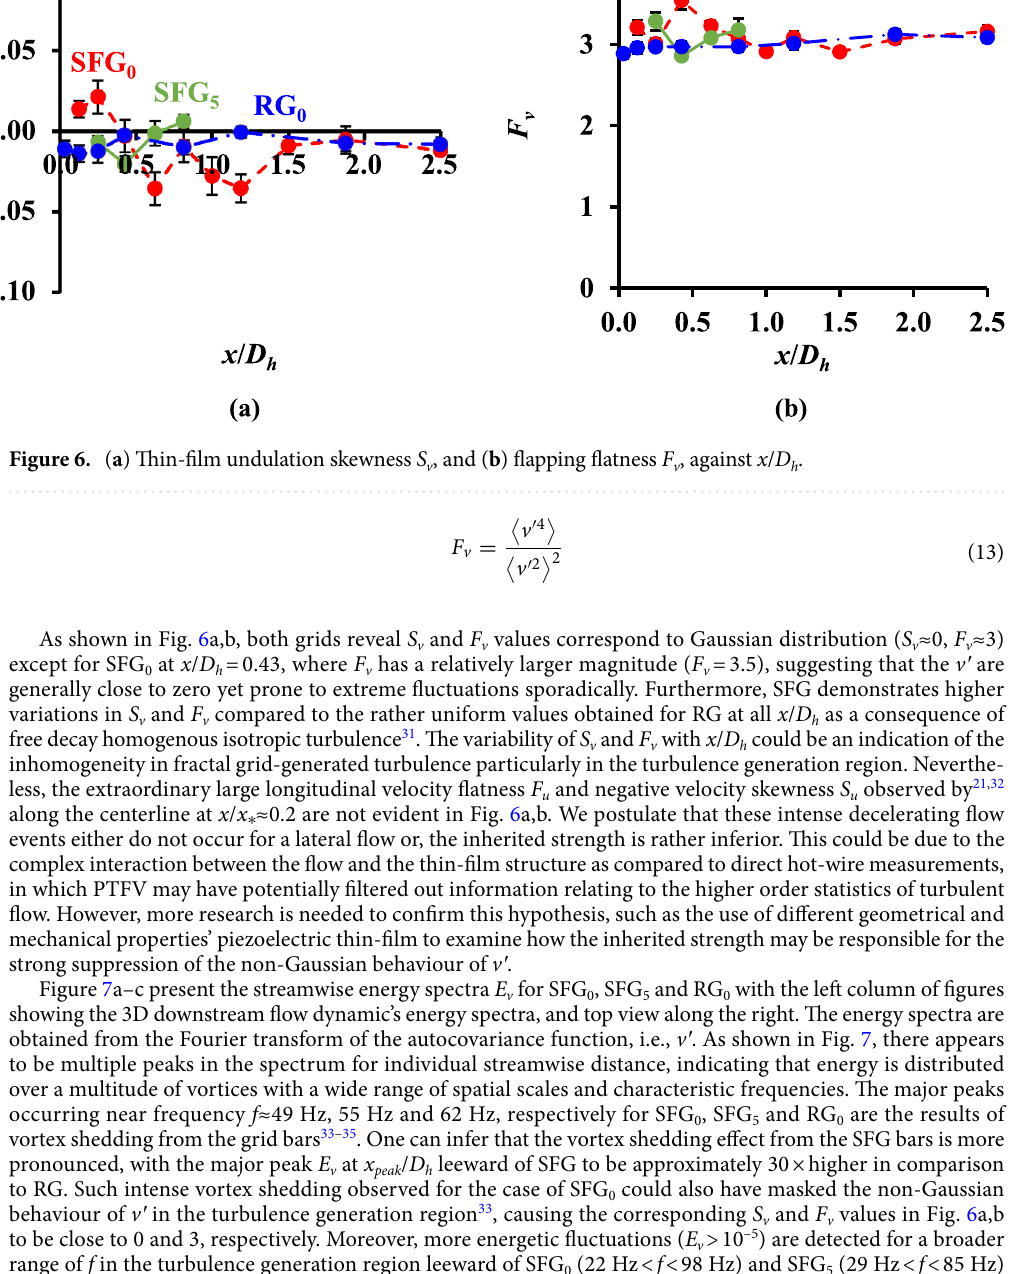
As shown in Fig. 6a,b, both grids reveal S v and F v values correspond to Gaussian distribution ( S v ≈0, F v ≈3) except for SFG 0 at x / D h = 0.43, where F v has a relatively larger magnitude ( F v = 3.5), suggesting that the v ′ are generally close to zero yet prone to extreme fluctuations sporadically. Furthermore, SFG demonstrates higher variations in S v and F v compared to the rather uniform values obtained for RG at all x / D h as a consequence of free decay homogenous isotropic turbulence 31 . The variability of S v and F v with x / D h could be an indication of the inhomogeneity in fractal grid-generated turbulence particularly in the turbulence generation region. Neverthe- less, the extraordinary large longitudinal velocity flatness F u and negative velocity skewness S u observed by 21,32 along the centerline at x / x ≈0.2 are not evident in Fig. 6a,b. We postulate that these intense decelerating flow ∗ events either do not occur for a lateral flow or, the inherited strength is rather inferior. This could be due to the complex interaction between the flow and the thin-film structure as compared to direct hot-wire measurements, in which PTFV may have potentially filtered out information relating to the higher order statistics of turbulent flow. However, more research is needed to confirm this hypothesis, such as the use of different geometrical and mechanical properties’ piezoelectric thin-film to examine how the inherited strength may be responsible for the strong suppression of the non-Gaussian behaviour of v ′ . Figure 7a–c present the streamwise energy spectra E v for SFG 0 , SFG 5 and RG 0 with the left column of figures showing the 3D downstream flow dynamic’s energy spectra, and top view along the right. The energy spectra are obtained from the Fourier transform of the autocovariance function, i.e., v ′ . As shown in Fig. 7, there appears to be multiple peaks in the spectrum for individual streamwise distance, indicating that energy is distributed over a multitude of vortices with a wide range of spatial scales and characteristic frequencies. The major peaks occurring near frequency f ≈49 Hz, 55 Hz and 62 Hz, respectively for SFG 0 , SFG 5 and RG 0 are the results of vortex shedding from the grid bars 33–35 . One can infer that the vortex shedding effect from the SFG bars is more pronounced, with the major peak E v at x peak / D h leeward of SFG to be approximately 30 × higher in comparison to RG. Such intense vortex shedding observed for the case of SFG 0 could also have masked the non-Gaussian behaviour of v ′ in the turbulence generation region 33 , causing the corresponding S v and F v values in Fig. 6a,b to be close to 0 and 3, respectively. Moreover, more energetic fluctuations ( E v > 10 –5 ) are detected for a broader range of f in the turbulence generation region leeward of SFG 0 (22 Hz < f < 98 Hz) and SFG 5 (29 Hz < f < 85 Hz) as compared to RG 0 (53 Hz < f < 69 Hz), suggesting that SFG-induced turbulence contains more effective flow structures contributing to the thin-film undulation. The f corresponding to the major peaks for all three cases are in excellent agreement with the f V and f δ deter- mined earlier in Fig. 5b, of which, they are associated to the first resonant mode of piezoelectric beam amalgamate with their respective vortex shedding frequencies. In addition, the streamwise evolution of the maximum E v are consistent with the trend previously observed in Fig. 5a,c. One can therefore deduce that more energetic vortex shedding gives rise to higher turbulence intensity flow that yields larger film bending and consequently higher voltage output. On the other hand, minor peaks with relatively smaller E v tend to appear at higher f close to the second vibration mode of the piezoelectric beam. These peaks are more marked in RG in comparison with SFG, especially in the domain proximate to grid, denoting that higher frequency small-scale eddies possess more significant contribution to RG-induced turbulence. As one proceeds downstream in the decay region, both the mechanically deduced major and minor peaks diminish due to viscous dissipation, with the minor peak intensity of RG attenuating up to 3× faster than its major peak, since smaller eddies of higher characteristic frequencies decay faster.